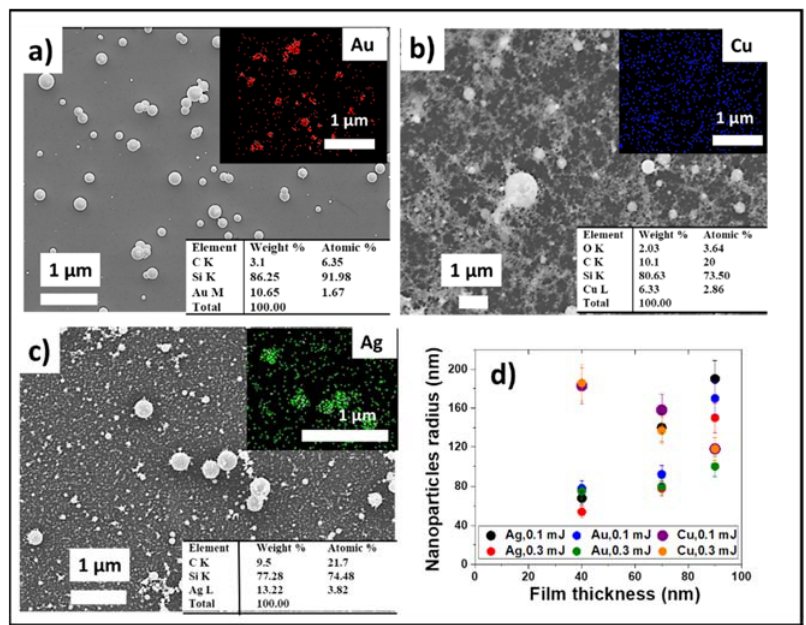
Figure 4. The SEM and EDX characterization of the transferred nanoparticles ( a ) Au, ( b ) Cu, ( c ) Ag; dependence of the particle sizes on the laser pulse energy and film thickness ( d ).